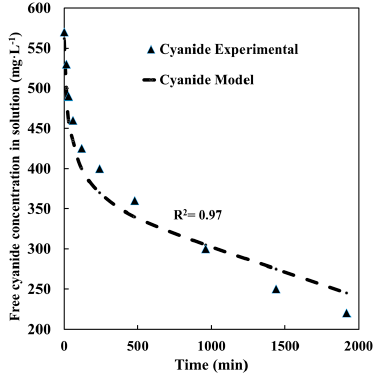
Figure 4. Free cyanide concentrations in solution for the chalcopyrite leaching system.